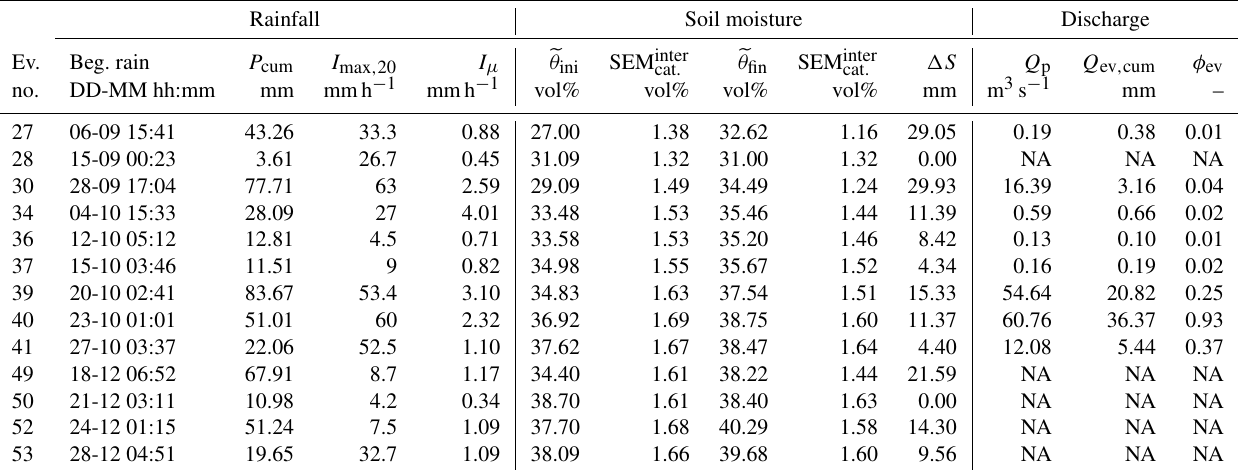
Table 4. Rainfall, soil moisture and discharge characteristics of selected rain events in autumn 2013 in the Claduègne catchment; abbrevia- tions as in Table 3. Rainfall Soil moisture Discharge